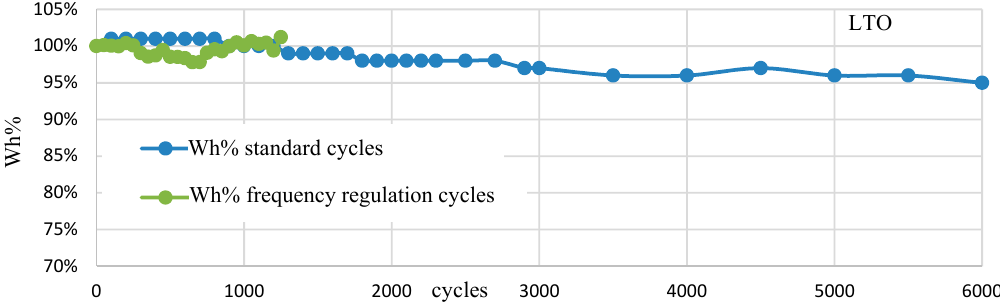
Figure 11. Lithium titanate (LTO) technology: comparison between the expected ageing, declared in the tender phase, and the ageing after the standard and frequency regulation cycles.